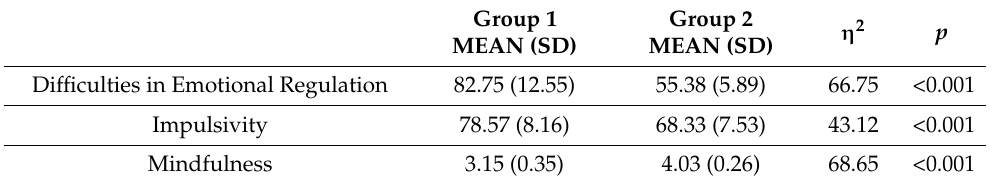
Table 2. Mean scores, standard deviations for Groups 1 and 2 on the DERS, BIS-11 and MAAS